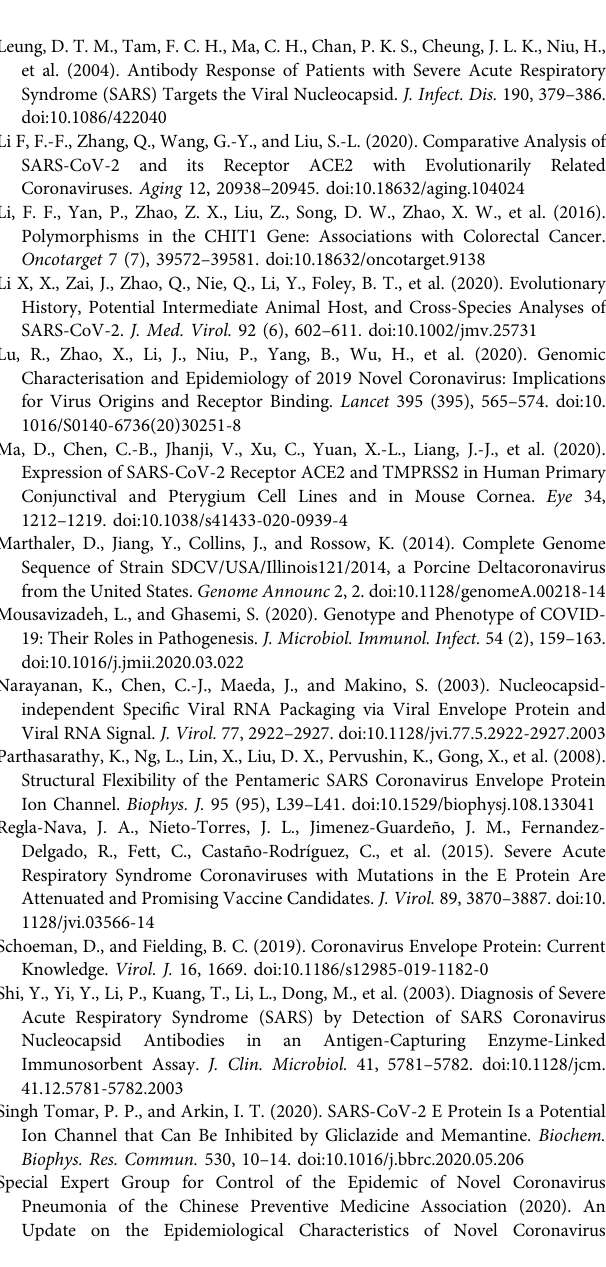
Supplementary Figure S1 | In fl uence of a mutation in the M gene (g.208G → A, p.70Val → Ile) of the MT263397 coronavirus on protein structure and function. The mutation had little effect on the transmembrane segment of the M protein. Supplementary Figure S2 | In fl uence of mutations in the N genes of 200 severe acute respiratory syndrome coronavirus-2 (SARS-CoV-2) isolates on protein structure and function. Six mutations (MT259237, p.3Asp → Tyr; MT263429, p.194Ser → Leu; MT256917 and MT256918, p.197Ser → Leu; MT263410, p.208Ala → Gly; MT256924, p.238Gly → Cys; and MT263422, p.271Thr → Ile) had effects on protein hydrophobicity. Three mutations (MT259237, p.3Asp → Tyr;